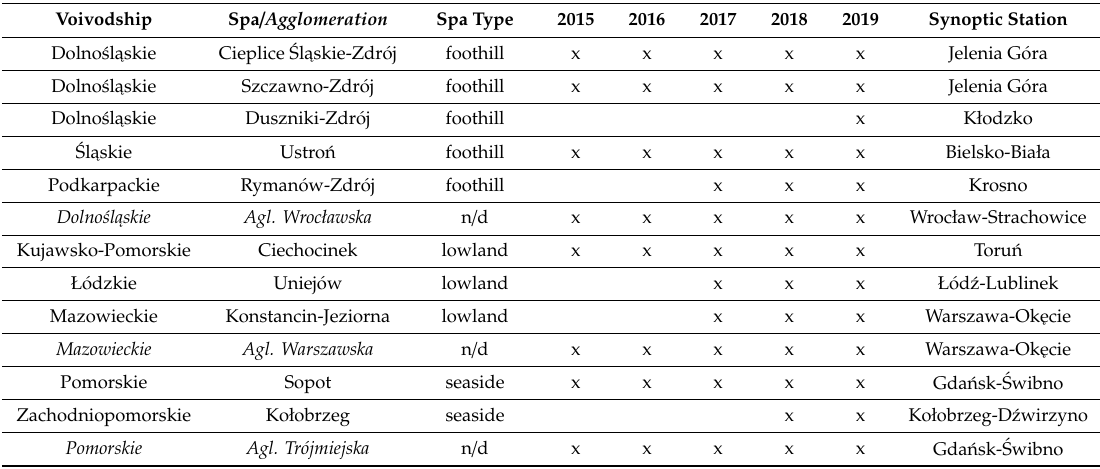
Table 2. Summary of the analyzed health resorts and agglomerations and available data.